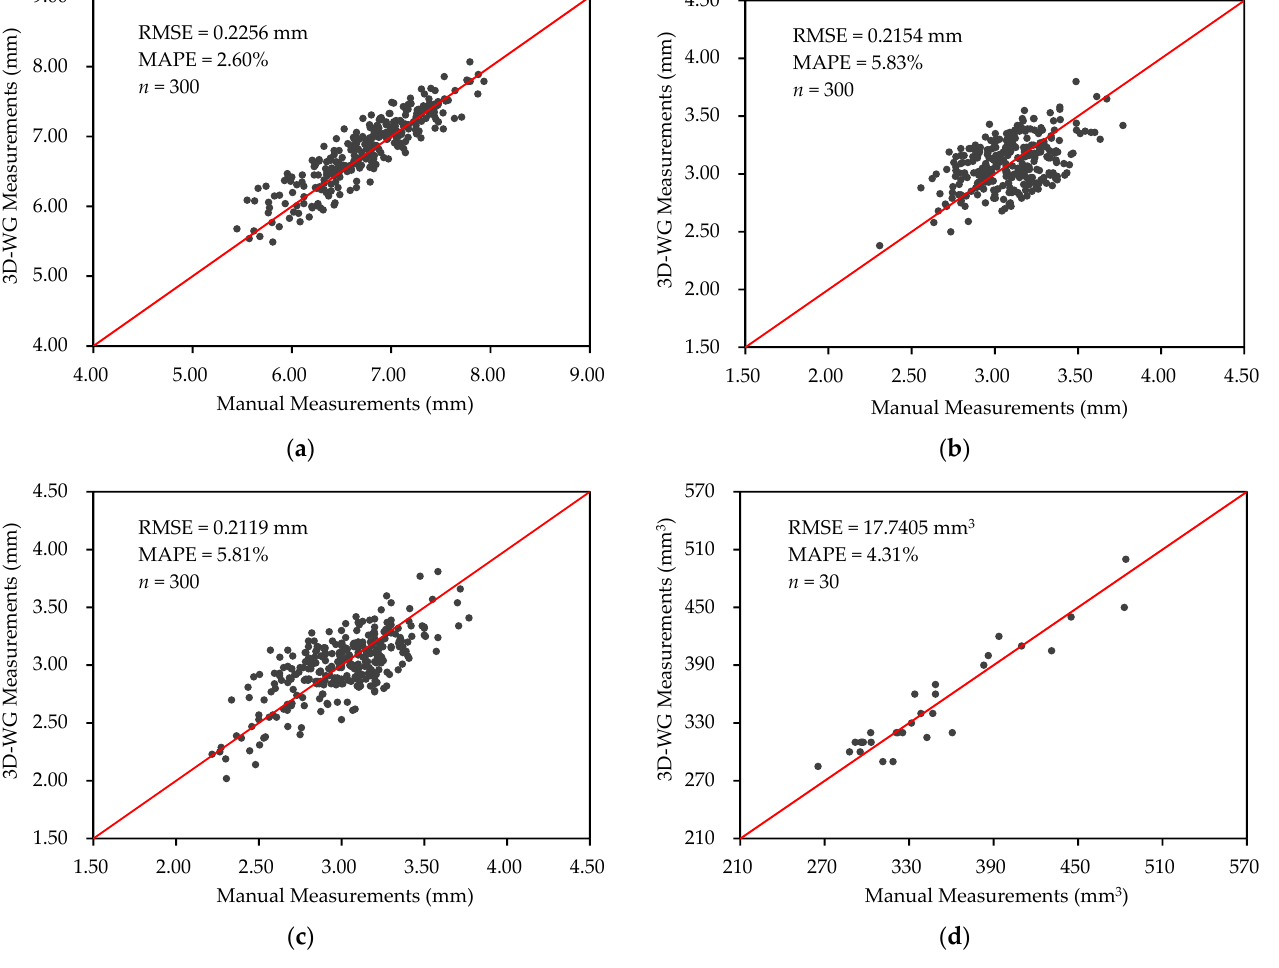
Figure 10. The sample accuracy analysis. ( a ) Length, ( b ) width, ( c ) thickness, ( d )volume.